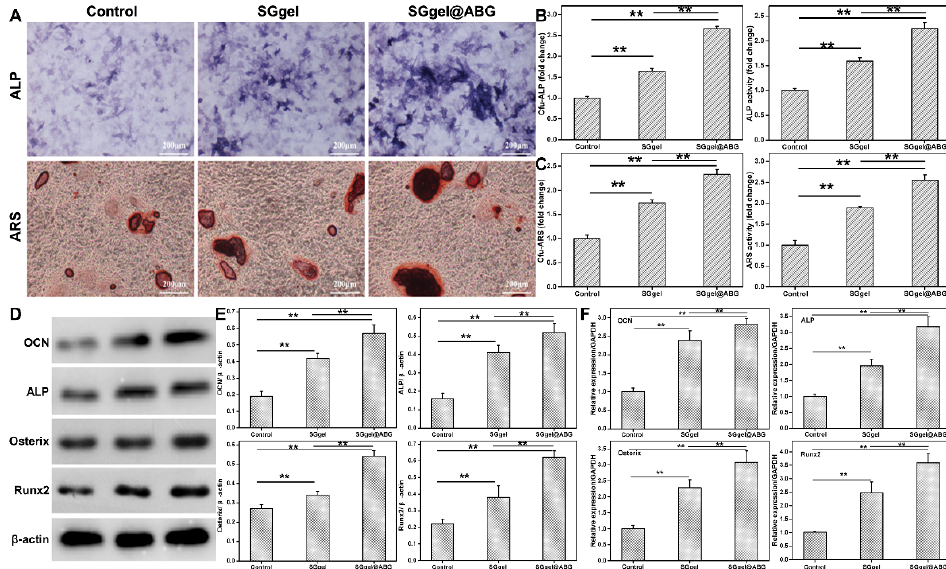
Figure 4. In vitro osteogenic differentiation of SGgel@ABG hydrogel. ( A – C ) ALP (14 d) and ARS staining (21 d) revealing the enhanced osteogenic differentiation of BMSCs. ( D , E ) Western blotting analysis and ( F ) qPCR quantification showing the highest osteogenic expression markers (OCN, ALP, Osterix and RUNX2) in the hydrogels. Statistically significant differences in comparison with untreated cells (control), SGgel hydrogel and SGgel@ABG hydrogel. * p < 0.05, ** p < 0.01.